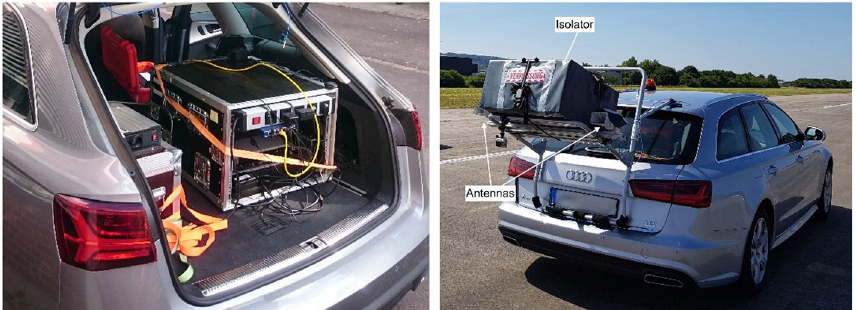
Fig. 23 Assembly of the demonstrator to a moving platform. The antennas are mounted to the rear of the car, whereas the main parts of the demonstrator are fixed inside the trunk of the car along with a mobile power